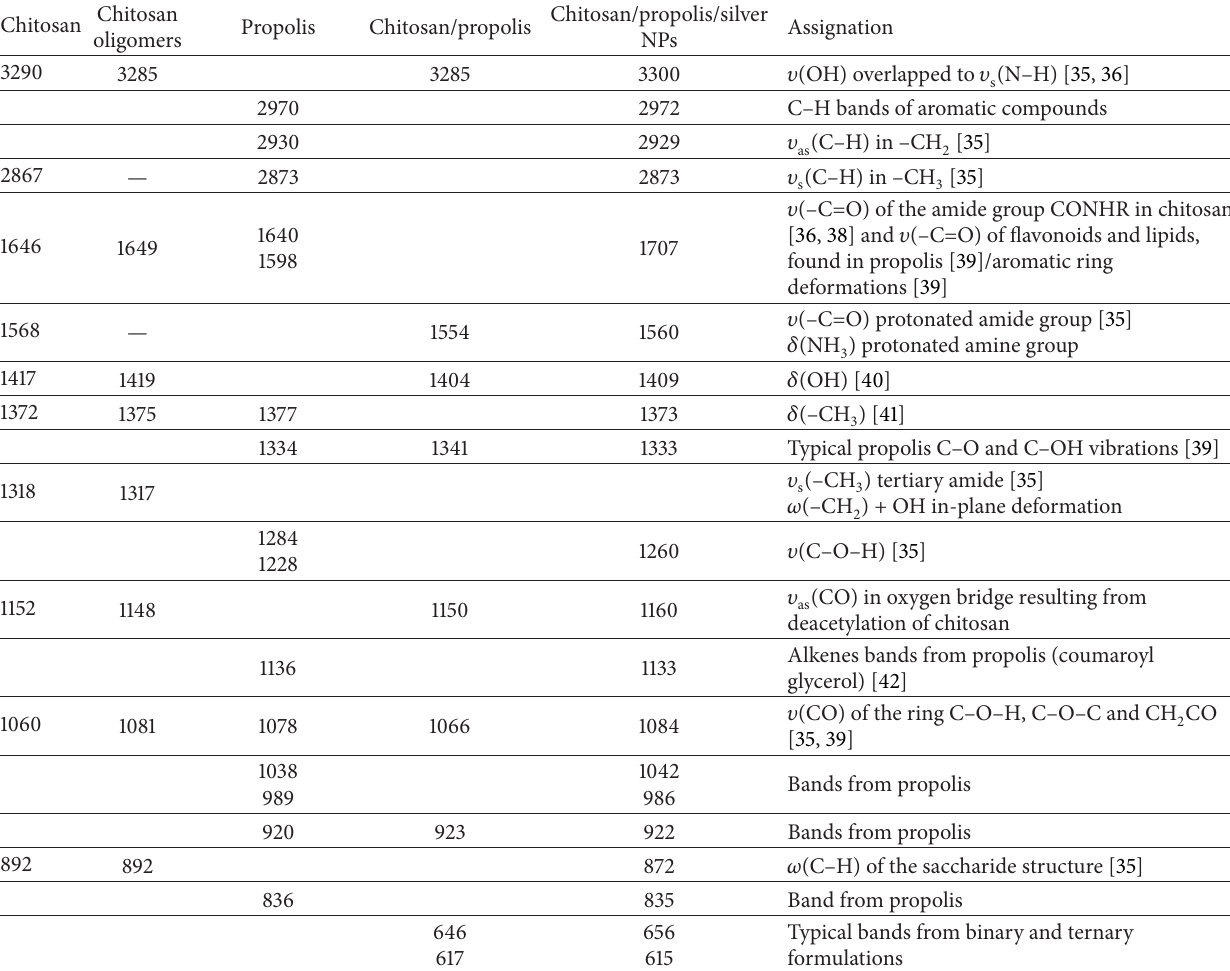
Table 2: Assignment of FTIR spectra